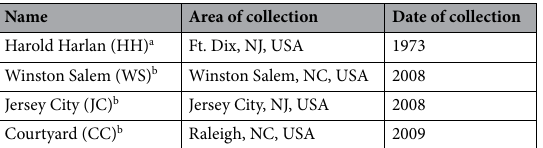
Table 1. Bed bug populations used in this study. a Standard laboratory population. b Apartment-collected